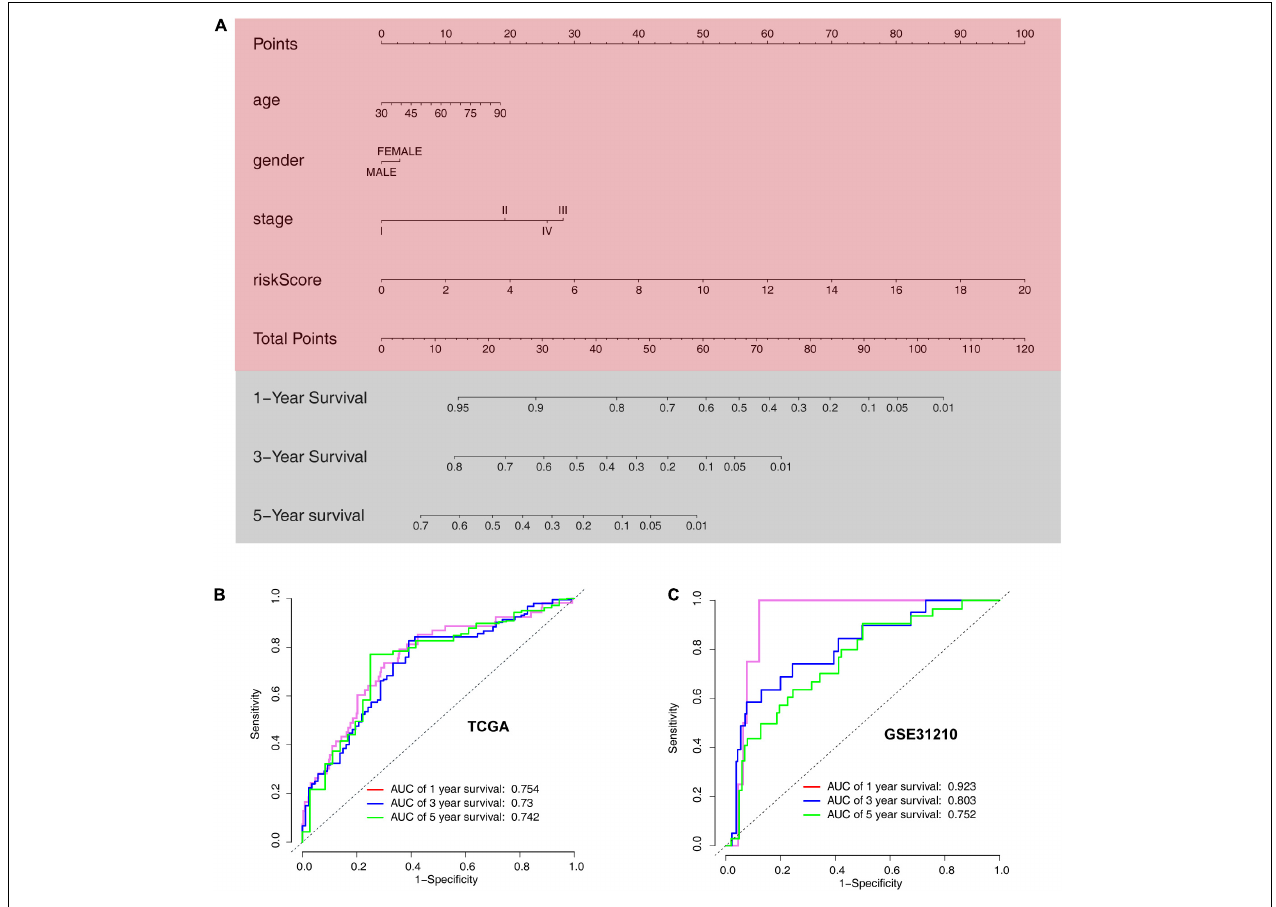
FIGURE 9 | Development of a nomogram model based on clinical characteristics and the 6-ARG signature. (A) Nomogram model combined with stage, age, and ARG signature. (B) Receiver operating characteristic curves for model-based overall survival prediction. (C) Receiver operating characteristic curves for model-based relapse-free survival prediction.